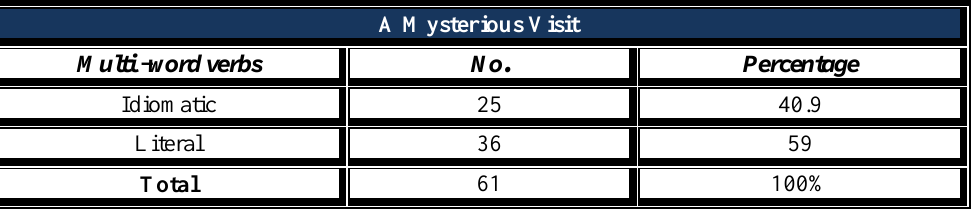
Table (5) reveals the number of idiomatic and literal PVs and their percentages. It can be noticed that the category with the highest percentage is literal PVs (59 %), whereas the lowest category is idiomatic PVs (40.9